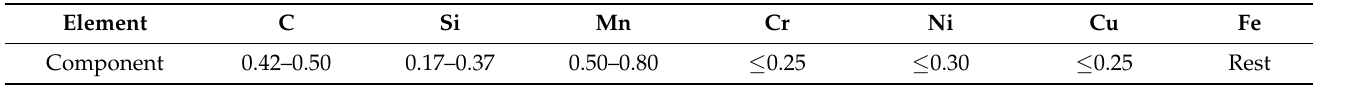
Table 2. Elemental composition (wt.%) of the AISI 1045 steel